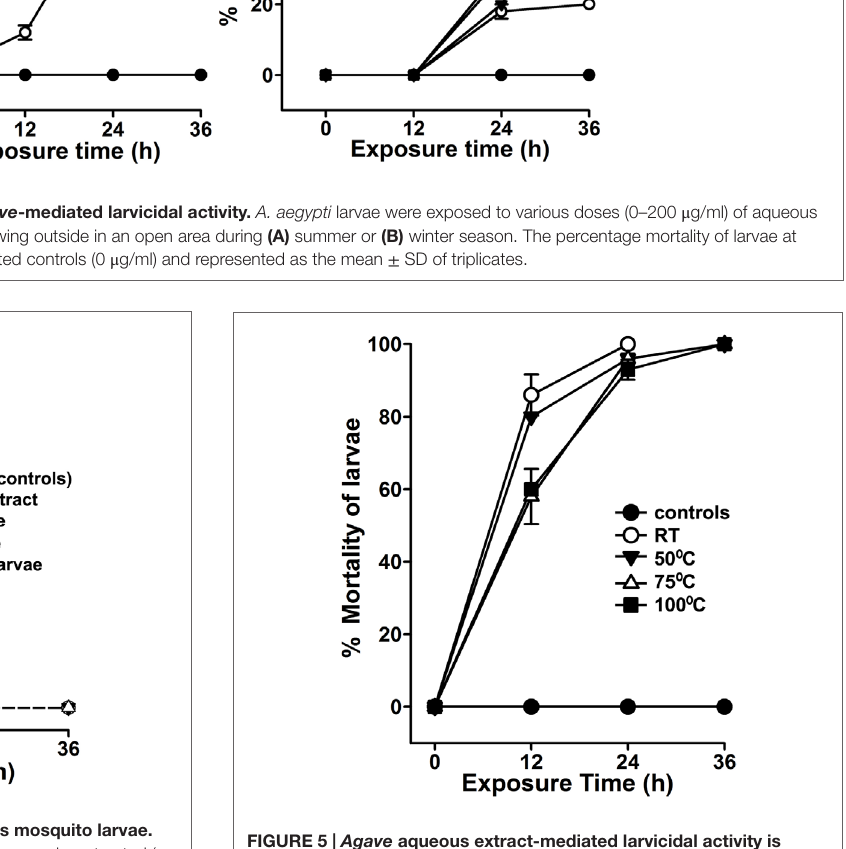
FigUre 5 | Agave aqueous extract-mediated larvicidal activity is highly thermostable. A. aegypti larvae were exposed to 100 μ g/ml Agave angustifolia aqueous extracts that were pre-incubated at different temperatures for 1 h. Percentage mortality of larvae was calculated at each time point against the sham-treated controls and represented as the mean ± SD of